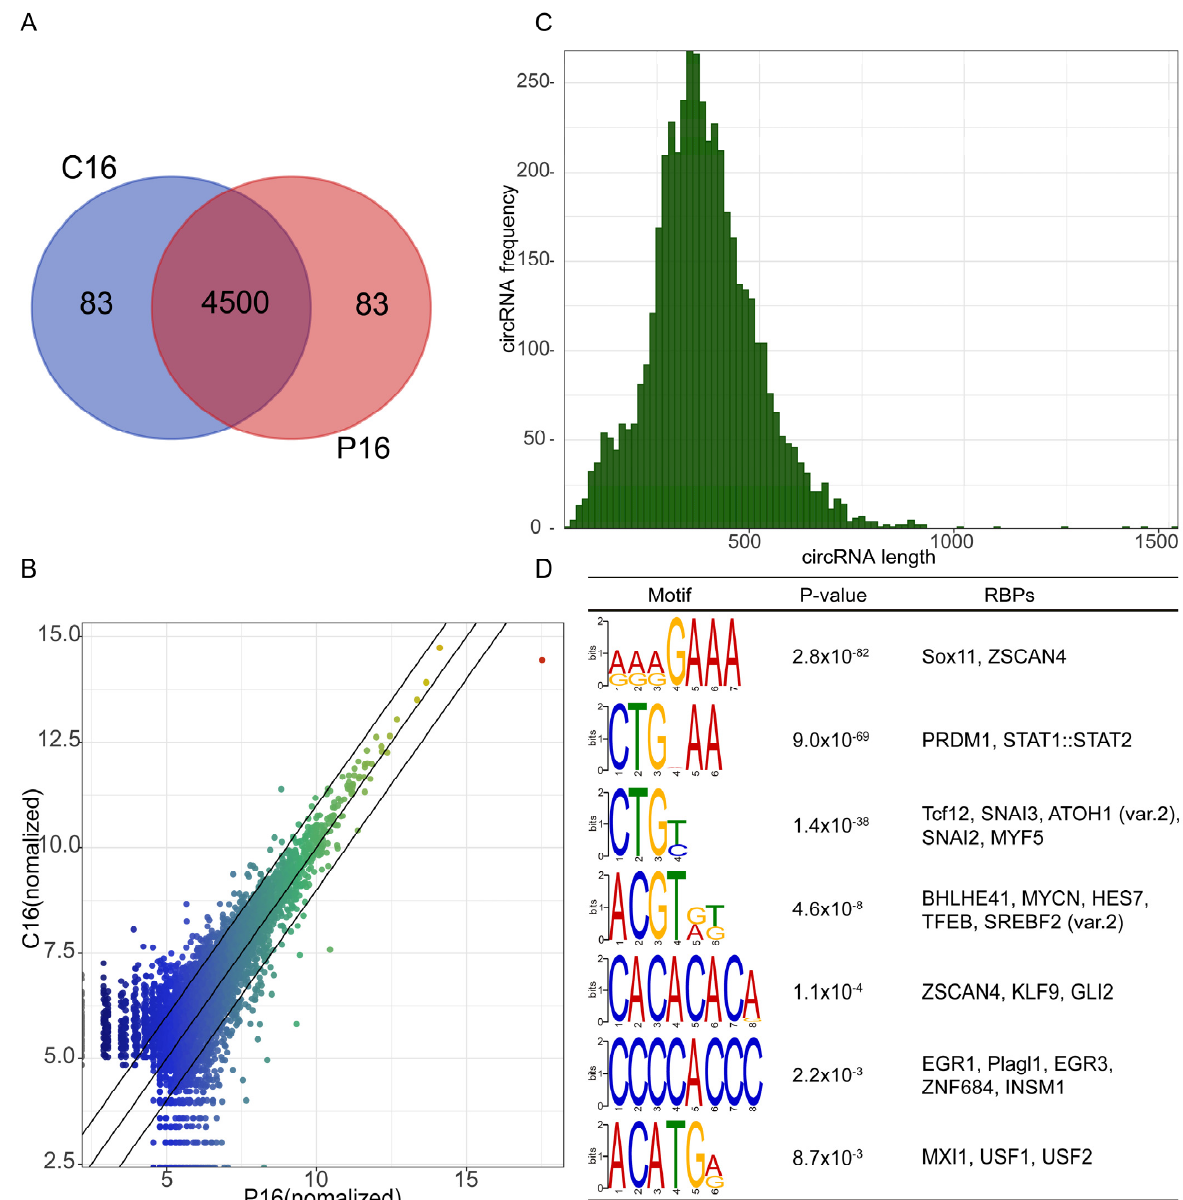
Figure 2. Characterization of circRNAs. ( A ) Venn diagram showing circRNAs co-expressed and specifically expressed in the goat endometrium of P16 and C16. ( B ) The overall analysis of the circRNA expression levels between the P16 and C16 endometrium. ( C ) The splice-length distribution of circRNAs. ( D ) The RRMs of RBPs enriched in the flanking regions of the circRNA junction sites.